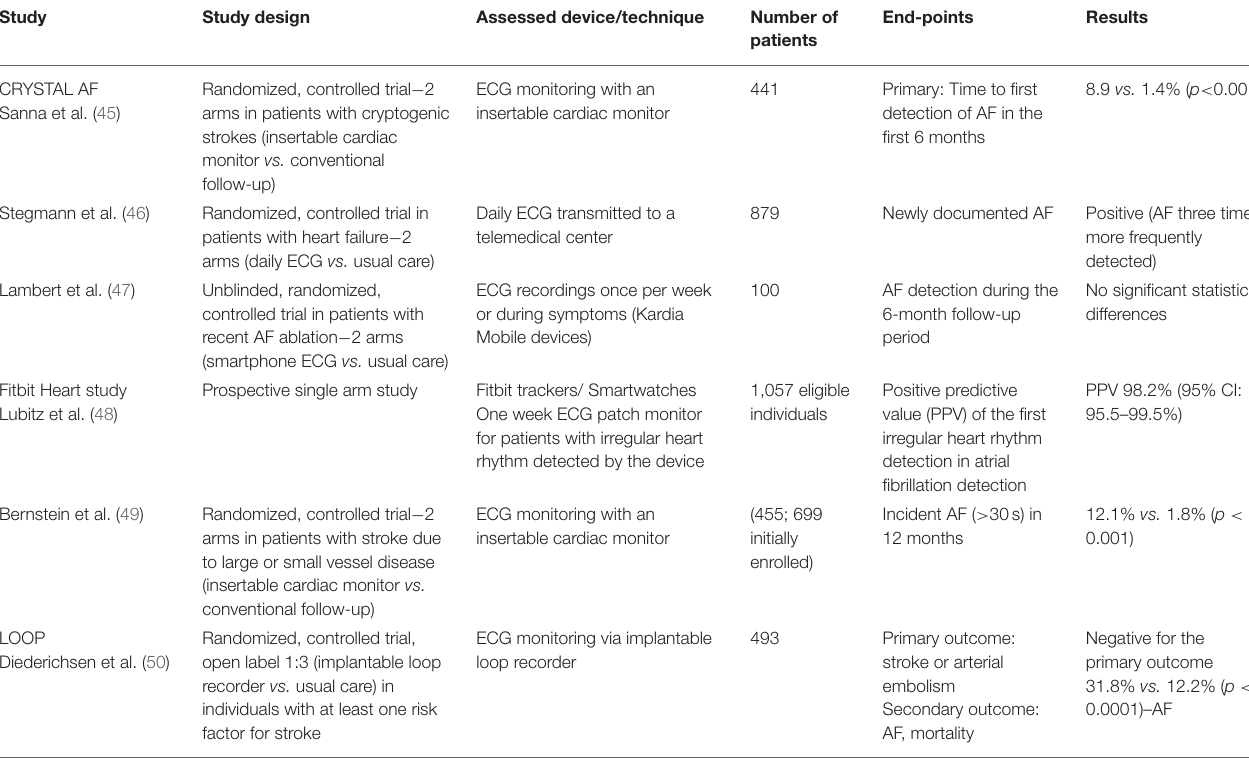
TABLE 4 | Summary of different atrial fibrillation telemedicine